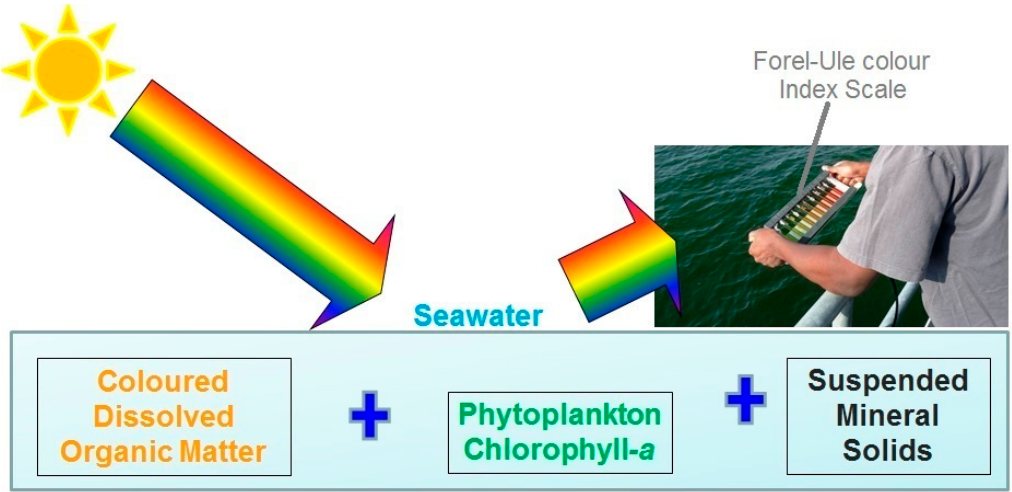
Figure 1. A schematic of the colour producing agents of water and a user observing the optical colour of seawater using a handheld Forel-Ule colour index scale. The Secchi-disk is not visible in the schematic but is held at half Secchi-disk depth.